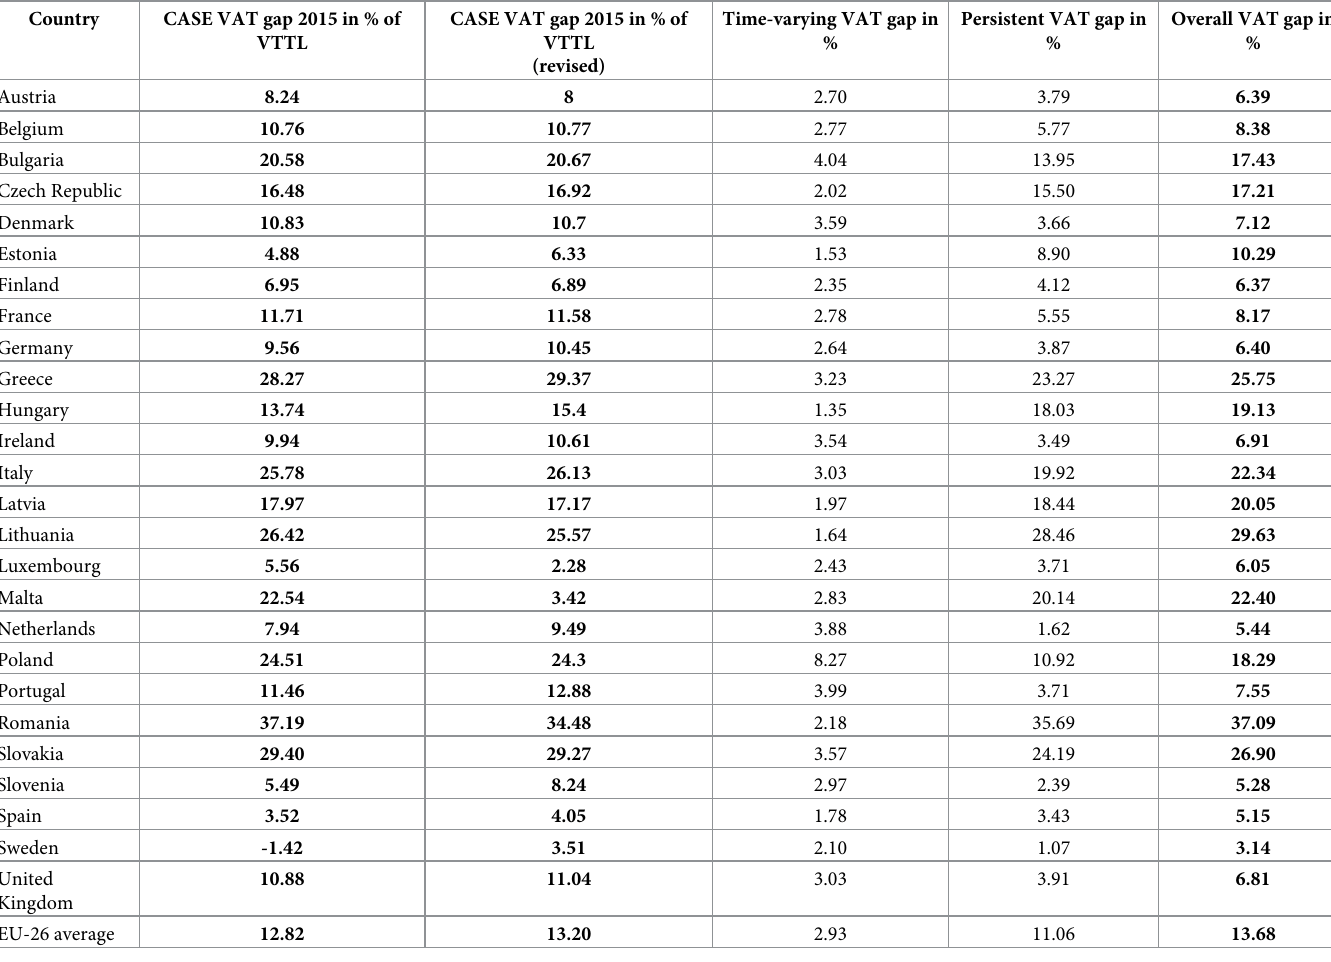
Table 8. Results from the panel data STFM estimation of VAT gap versus the VAT gap obtained by the CASE [4, 5] top-down method for 2015.